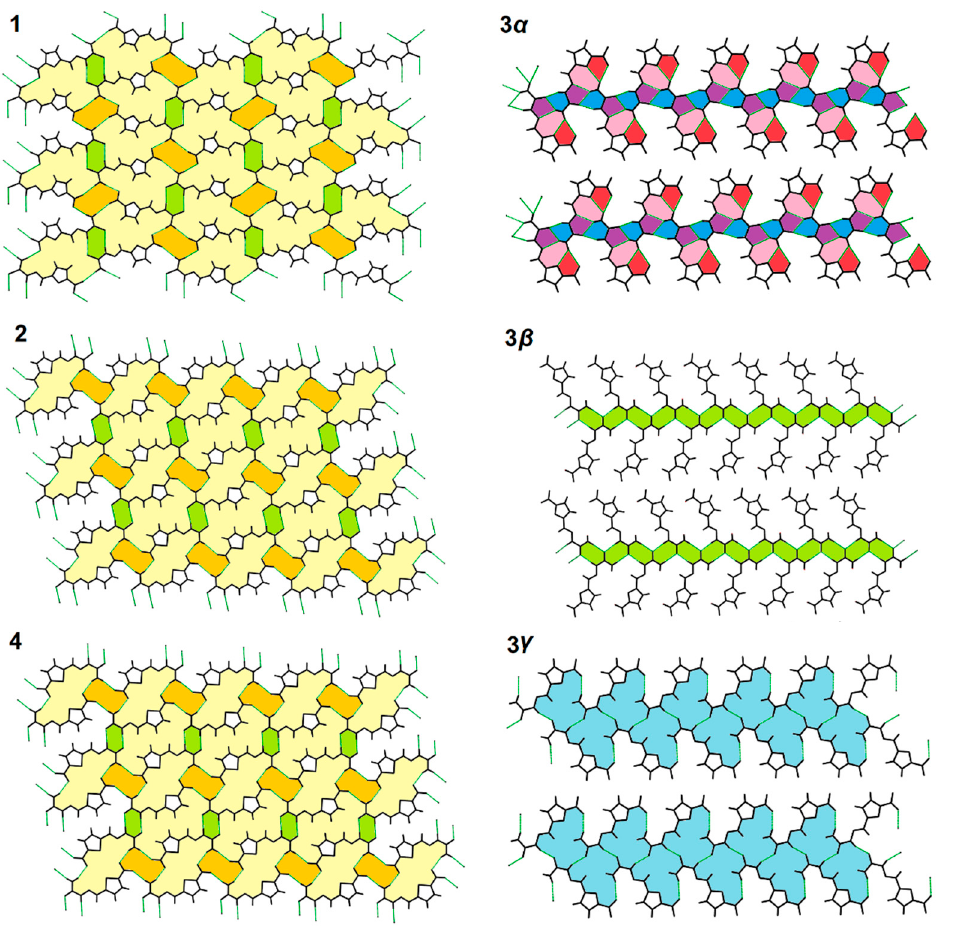
Figure 3. Tessellations in the studied compounds, created via hydrogen bonds assembling molecules in an appropriate crystallographic plane: (1 0 1) for 1 and 3 α , (2 1 1) for 2 and 4 , (3 0 1) for 3 β , (1 0 2) for 3 γ (for detailed description see text) .